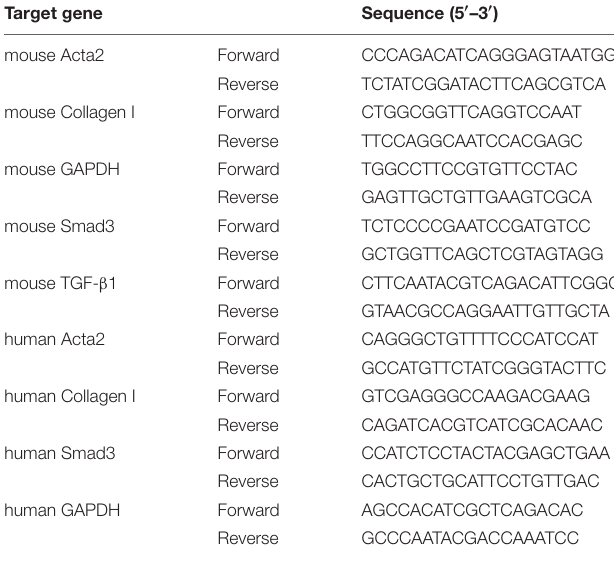
TABLE 1 | Primer sequences for Real − time quantitative polymerase chain reaction. Target